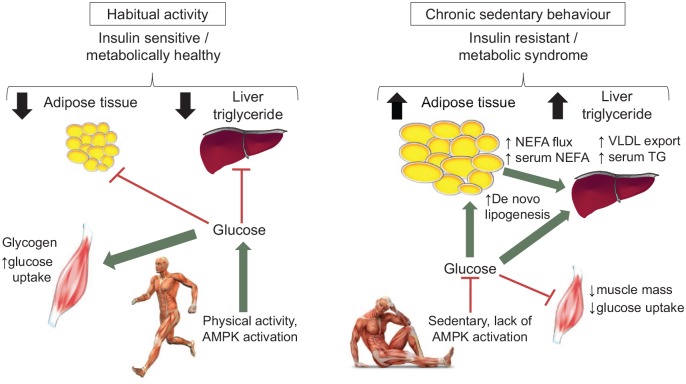
A two-part schematic representing the metabolic effects of habitual physical
activity (left) and chronic sedentary behaviour (inactivity; right).Left: a consequence of sedentary behaviour is diminished AMPK activation and
glucose uptake into skeletal muscle, inducing insulin resistance. The plasma
glucose (not transported into muscle) provides a substrate for de novo
lipogenesis in adipose tissue and liver. Consequently, there is expansion of
adipose tissue mass, intrahepatic lipid accumulation and increased lipid
export from the liver as VLDL triacylglycerol particles and serum
triacylglycerol with induction of systemic insulin resistance.Right: being habitually active stimulates AMPK activation and glucose uptake
into skeletal muscle; insulin sensitivity is therefore preserved and less
glucose is diverted to metabolically unfavourable depots.AMPK, AMP-activated protein kinase; NEFA, nonesterified fatty acids; TG,
triglyceride; VLDL, very low-density lipoproteins.